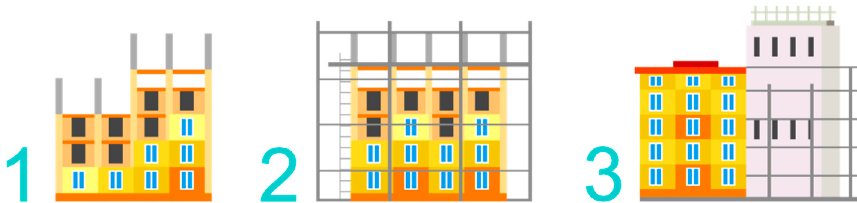
Figure 18. Three types of reconstruction (according to A.V. Krotov): ( 1 ) the superstructure of a low-rise attic, ( 2 ) superstructure, building on separate foundations, ( 3 ) the extension of separate residential sections. (https://www.akrotov.ru (accessed on 15 January 2022)).